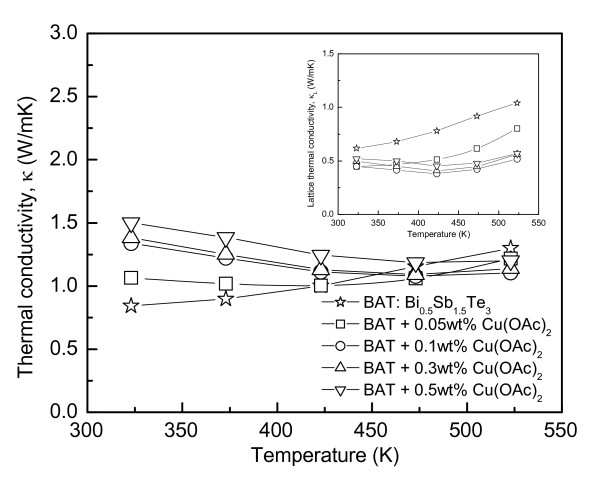
Thermal conductivity of Cu-dispersed Bi0.5Sb1.5Te3: The inset is the lattice thermal conductivity.